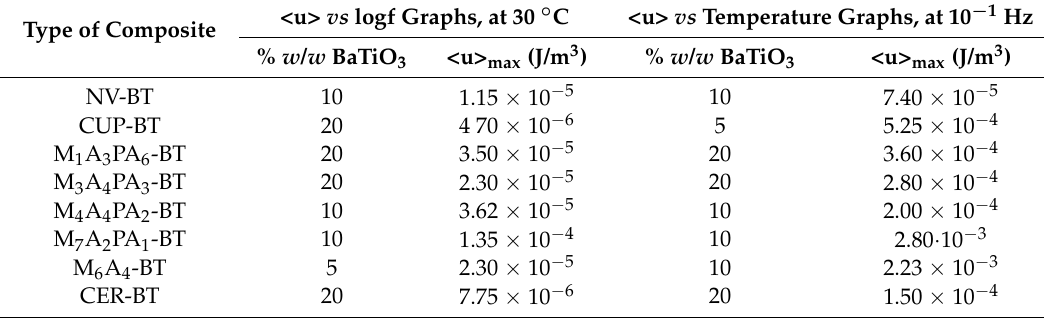
Table 10. Maximum energy density values versus frequency (at 30 ◦ C) and versus temperature (at 10 − 1 Hz), in relation to the composite’s content of barium titanate, for all developed categories of composite